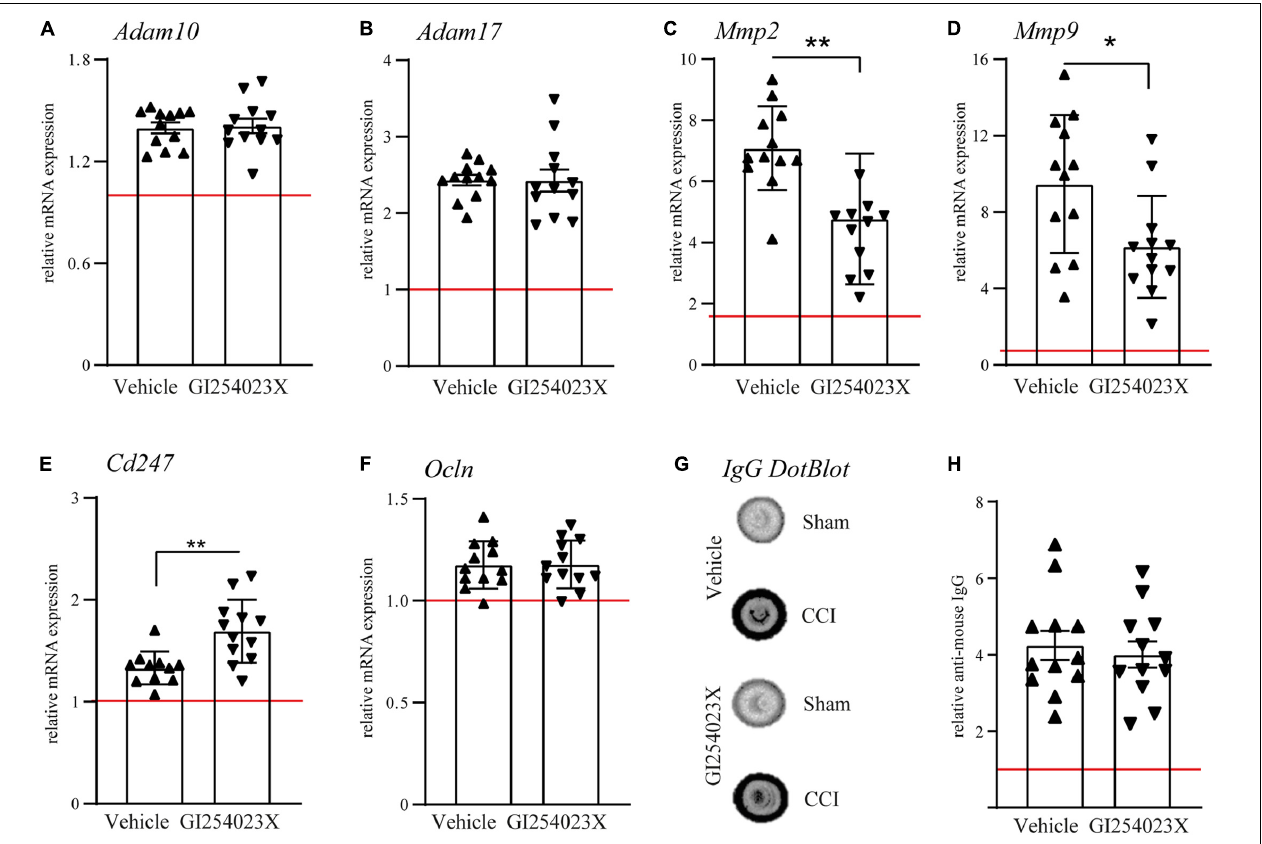
FIGURE 2 | GI254023X influences matrix metalloproteinase gene expression but not overall BBB integrity after TBI. (A–F) Histograms showing relative mRNA expression of ADAM10, ADAM17, MMP2, MMP9, CD3 CD3zeta ( Cd247 ), and Occludin ( Ocln) at 7 dpi in ipsilesional brain tissue samples. (G) Representative anti-IgG Dot-blot using 7 dpi protein lysates from ipsilesional brain tissue. (H) Densitometric quantification of IgG dot blots as a proxy of BBB damage. mRNA expression values were normalized to the reference gene Ppia (cyclophilin A) and data are shown relative to the corresponding sham group (red line = sham). P -values were calculated by Student’s t -test or Mann-Whitney test (* p < 0.05, ** p < 0.01). One outlier was removed after identification by ROUT’s test in (E) . Values from individual animals and mean ± SEM are shown.